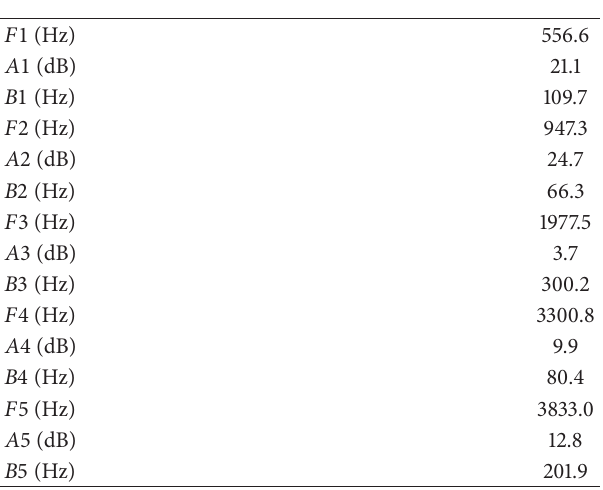
Table 4: Original values.